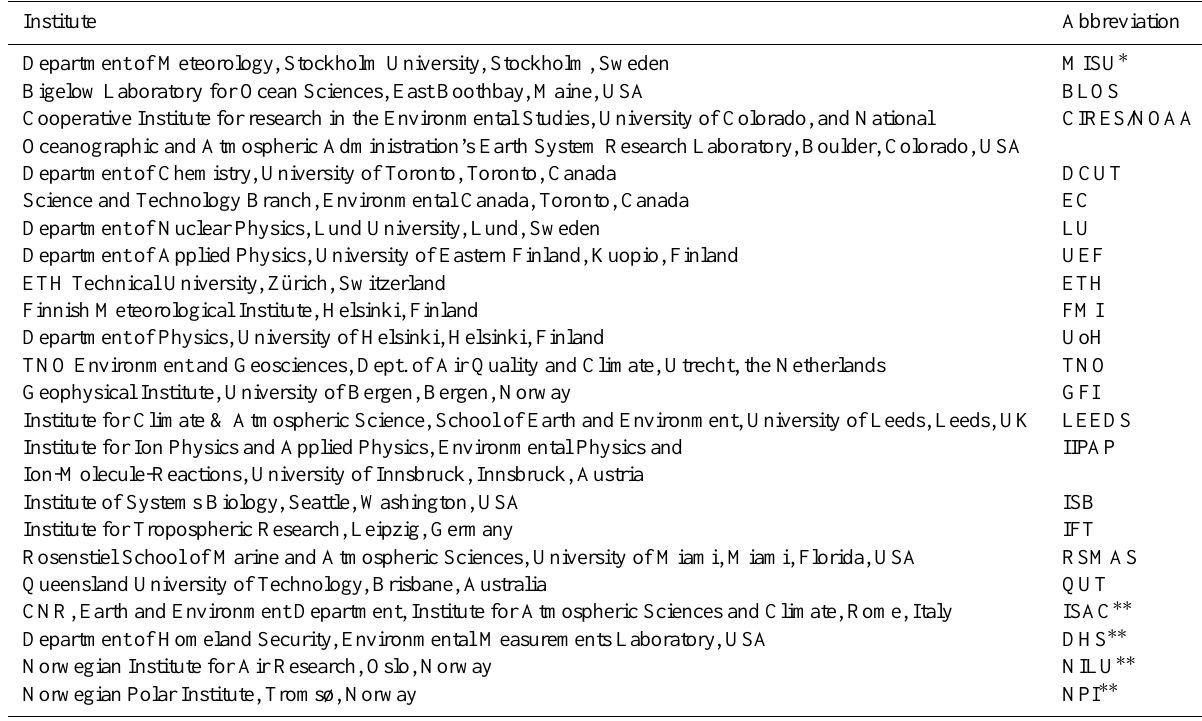
Table 2. Participating groups with respective